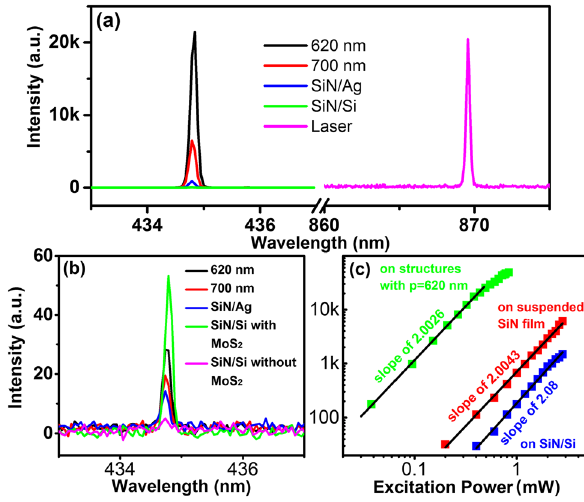
Figure3: Nonlinearsecond-harmonicgeneration(SHG)microscopy. (a) SHG spectra of monolayer MoS 2 on the different substrates (metallic structures with P = 620 nm (black) and P = 700 nm (red), SiN/Ag (blue) and SiN/Si (green) substrate) and typical spectrum (pink) of fundamental laser. (b) SHG spectra of the different sub- strates without monolayer MoS 2 . As a reference, SHG spectrum (green line) of the SiN/Si substrate with monolayer MoS 2 is also plotted in (b). (c) The dependence of the SHG intensity from mono- layerMoS 2 ondifferentsubstratesontheexcitationpowerplottedin log – log scale. Quadratic linear fi t is displayed by the black